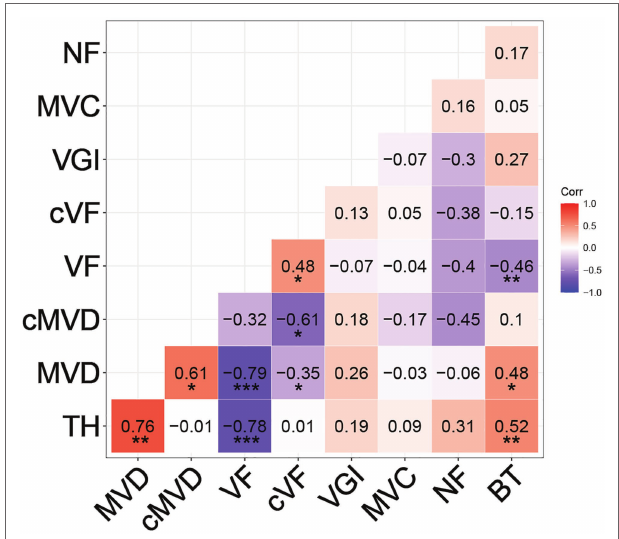
FIGURE 5 | Pearson correlation coefficients between different wood and stem traits. Traits include tree height at harvest (TH), MVD, cMVD, VF, cVF, VGI, MVC, non-lumen fraction (NF), and bark thickness (BT). Asterisks indicate significant correlations between traits (* p ≤ 0.05; ** p ≤ 0.01; *** p ≤